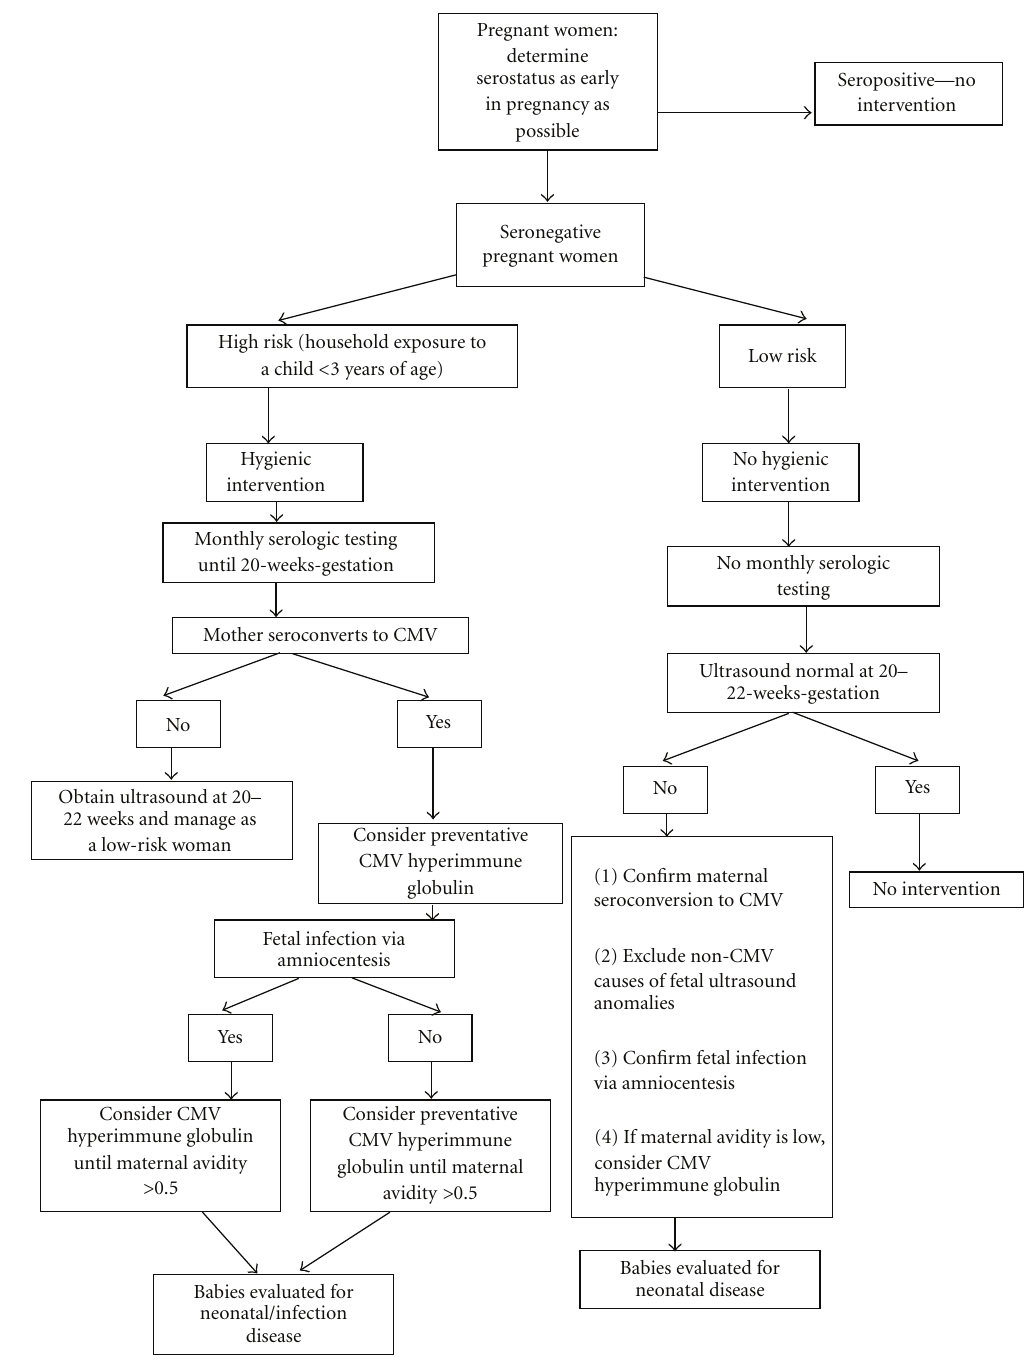
Figure 2: A possible algorithm for limited CMV screening during